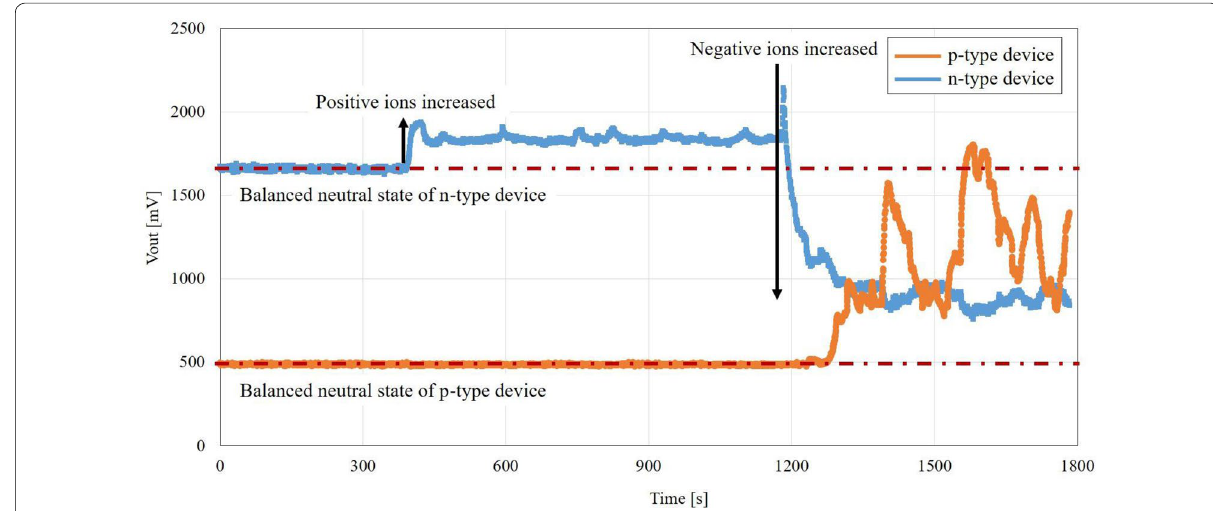
Fig. 5 Ion balance monitoring in real‑time with both n‑type and p‑type nanoFET